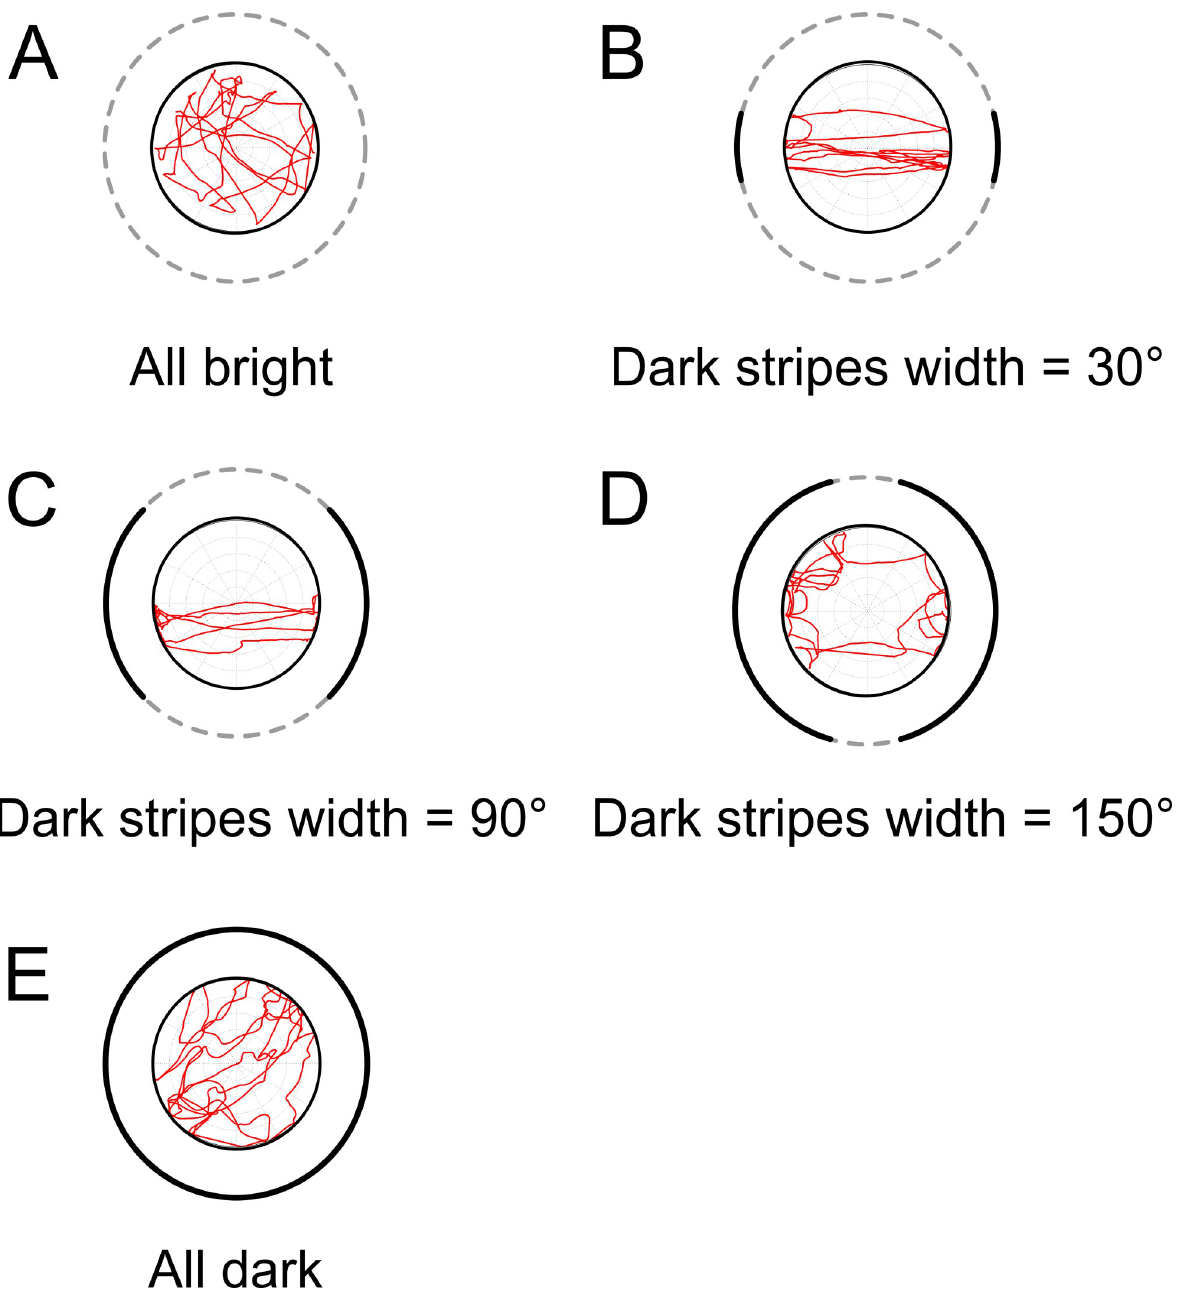
Fig 3. Example movement traces of the w + wild-type flies in five different stimulus conditions. (A) In the all-bright condition, in which no dark stripe was present, the fly did not exhibit any approach behavior. (B)-(D) Example movement traces for different dark stripe widths (30˚ (B), 90˚ (C) and 150˚ (D)). The approach behavior presented in all conditions, include those with very wide stripes. (E) No apparent approach behavior was observed for the all-dark